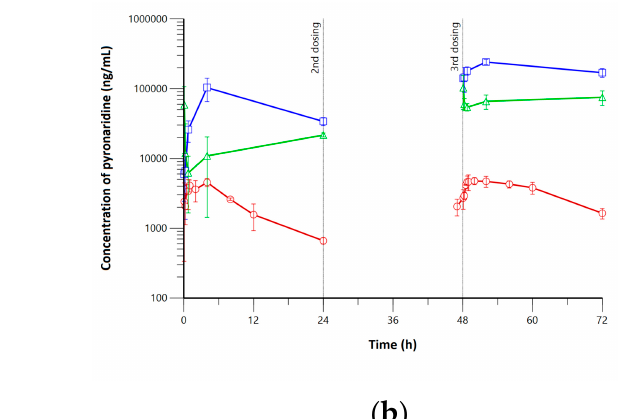
( b ) Figure 3. Blood concentrations for artesunate and dihydroartemisinin after multiple dosing of ( a ) low-dose (60 mg/kg) and ( b ) high-dose (120 mg/kg) artesunate to hamsters. Closed circles and open squares are blood concentrations of artesunate and dihydroartemisinin, respectively. 3.2. Development of Minimal Physiologically-Based Pharmacokinetic Models For accurate predictions of systemic, lung, and trachea exposure, the minimal PBPK models were developed using the observed PK profiles of pyronaridine, artesunate, and dihydroartemisinin. The minimal PBPK models in this study were modified from Jermain et al., which reported the minimal PBPK model of ivermectin for COVID-19 drug repur- posing [11]. Since the target organ for the antiviral effects of pyronaridine and artesunate were the lung and trachea, the nontarget tissues were lumped together into the rest of the